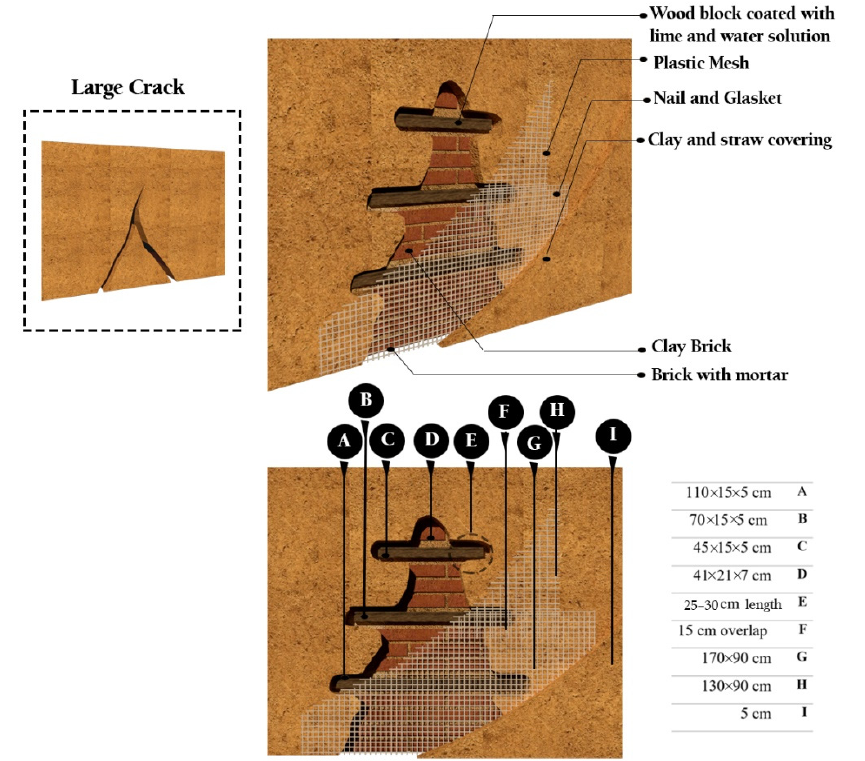
Figure 5. Example of architectural detail for conservation of a large crack in the wall (for instance, 80 cm width).